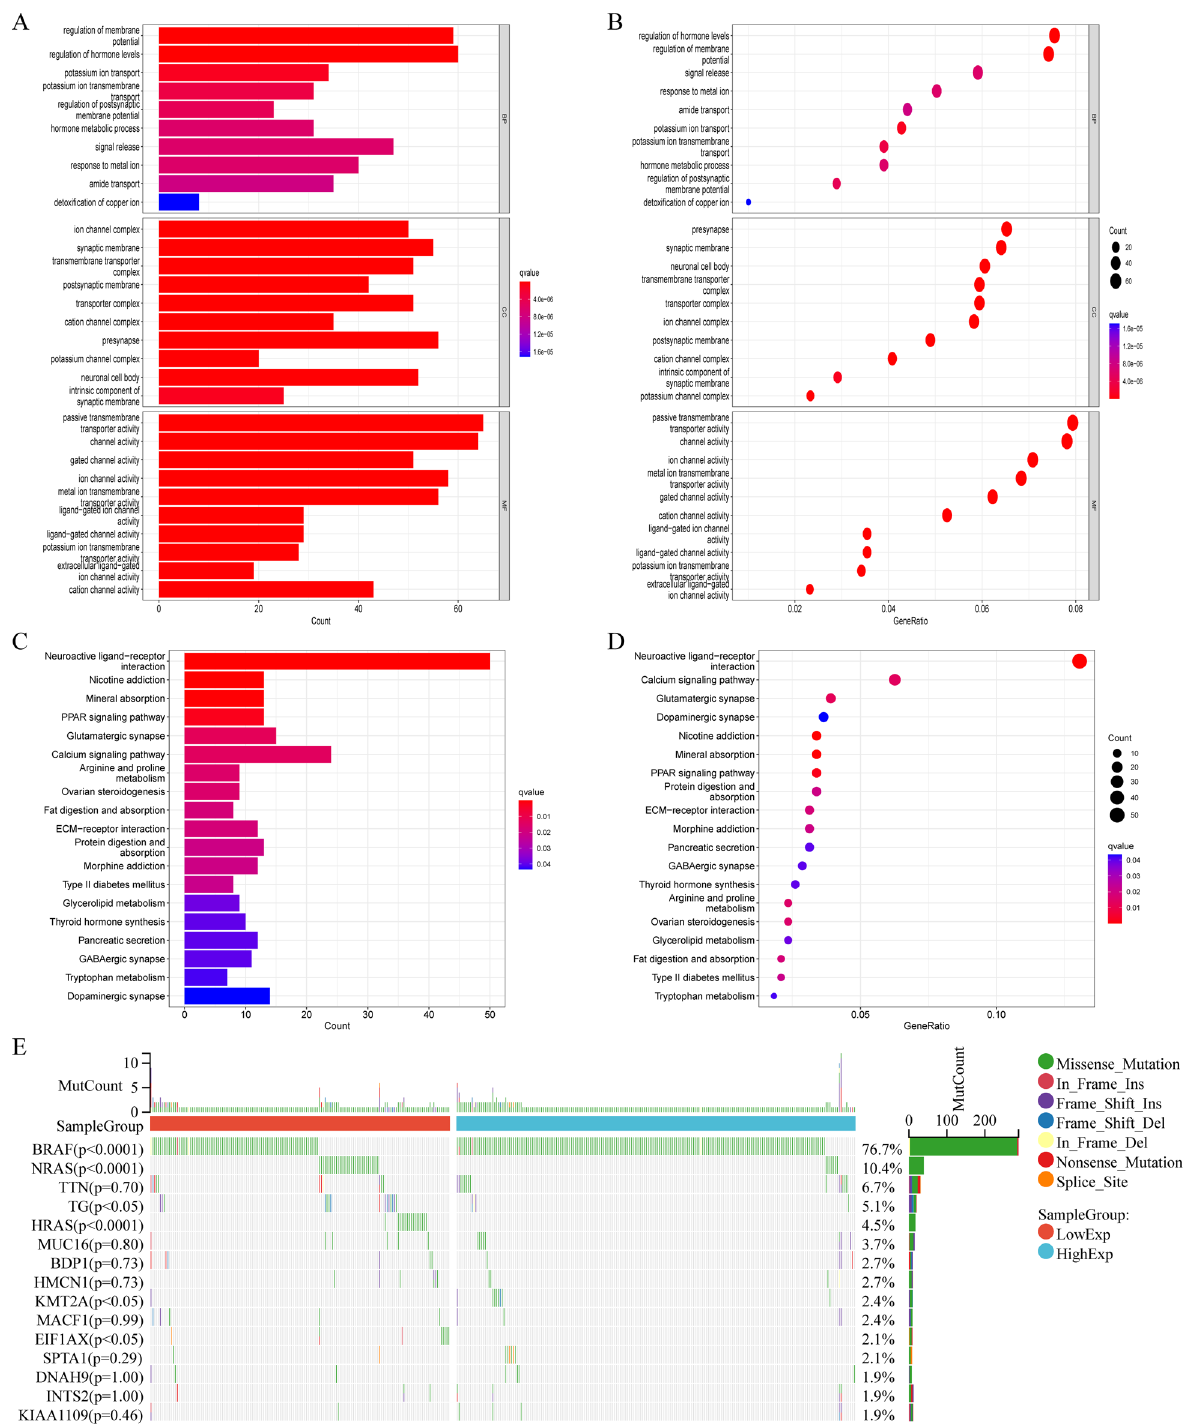
Figure 3. Gene ontology and Kyoto Encyclopedia of Genes and Genomes enrichment analysis and mutation frequency of tumor genes. ( A , B ) GO functional enrichment analysis shows that regulation of membrane potential, synaptic membrane, and passive transmembrane transporter activity are strongly associated with LPAR5 in the biological process, cell components, and molecular function. ( C , D ) Neuroactive ligand-receptor interaction is the most significant associated with LPAR5 in KEGG pathway enrichment analysis. ( E ) The mutation frequency of 6 tumor genes were significantly different between the high and low expression groups of LPAR5. [Figures created by R, version 4.1.3. Sangerbox website (version 3.0; http:// vip. sange rbox. com/ home.